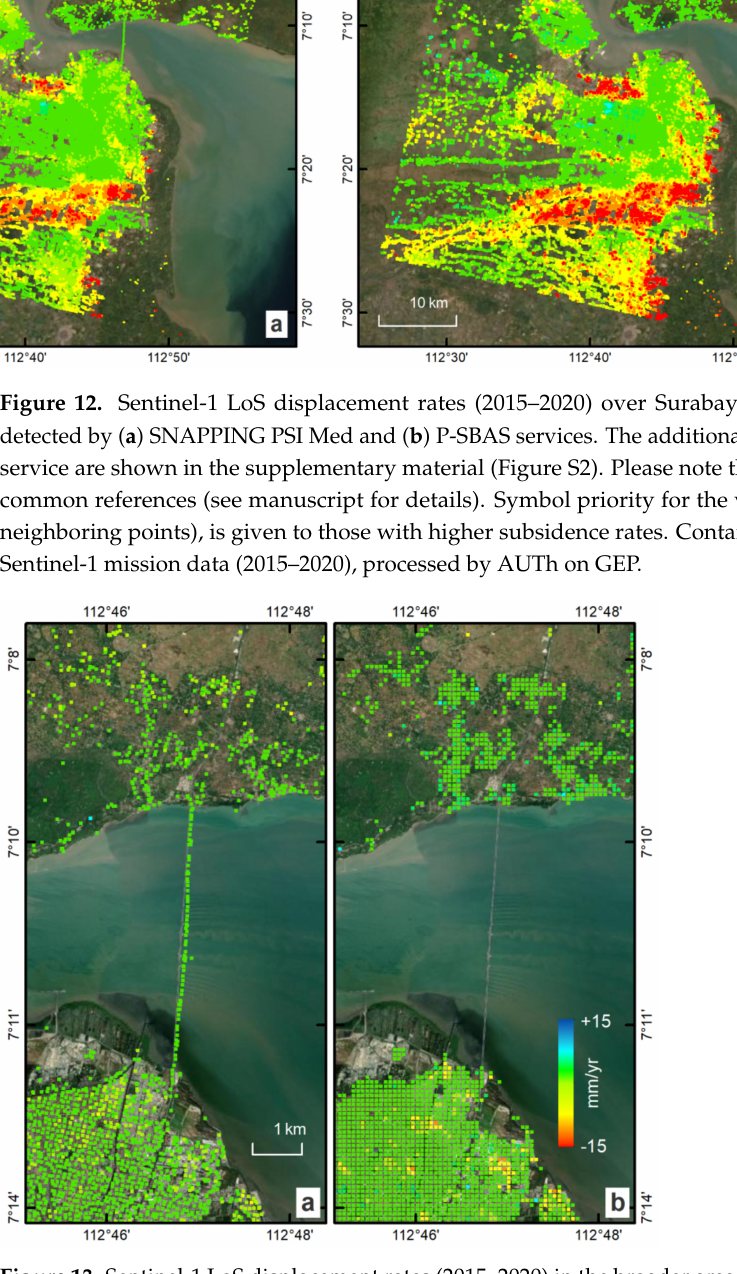
Figure 13. Sentinel-1 LoS displacement rates (2015–2020) in the broader area of the ‘Suramadu’ bridge connecting Surabaya and the island of ‘Madura’ in the North based on ( a ) SNAPPING PSI Med and ( b ) P-SBAS services. It is shown that the PSI approach is often more efficient in mapping linear infrastructure such as bridges and